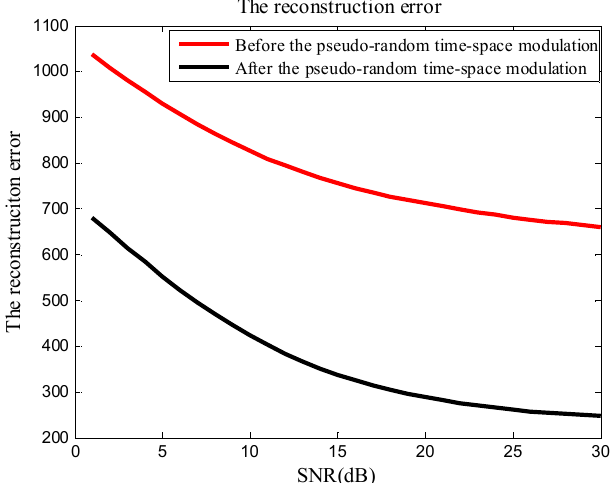
Figure 8. The reconstruction error before and after the pseudo-random time-space modulation.